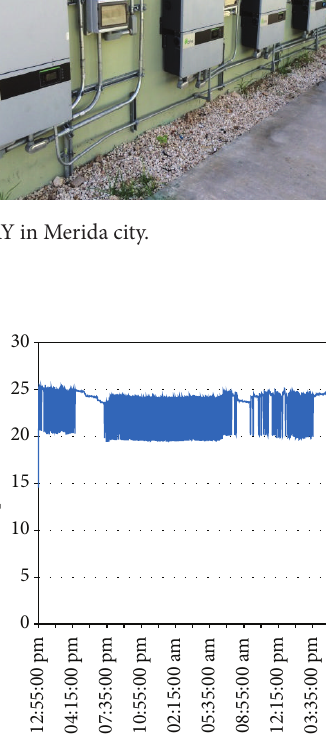
Figure 16: Power demand by Sewage Treatment